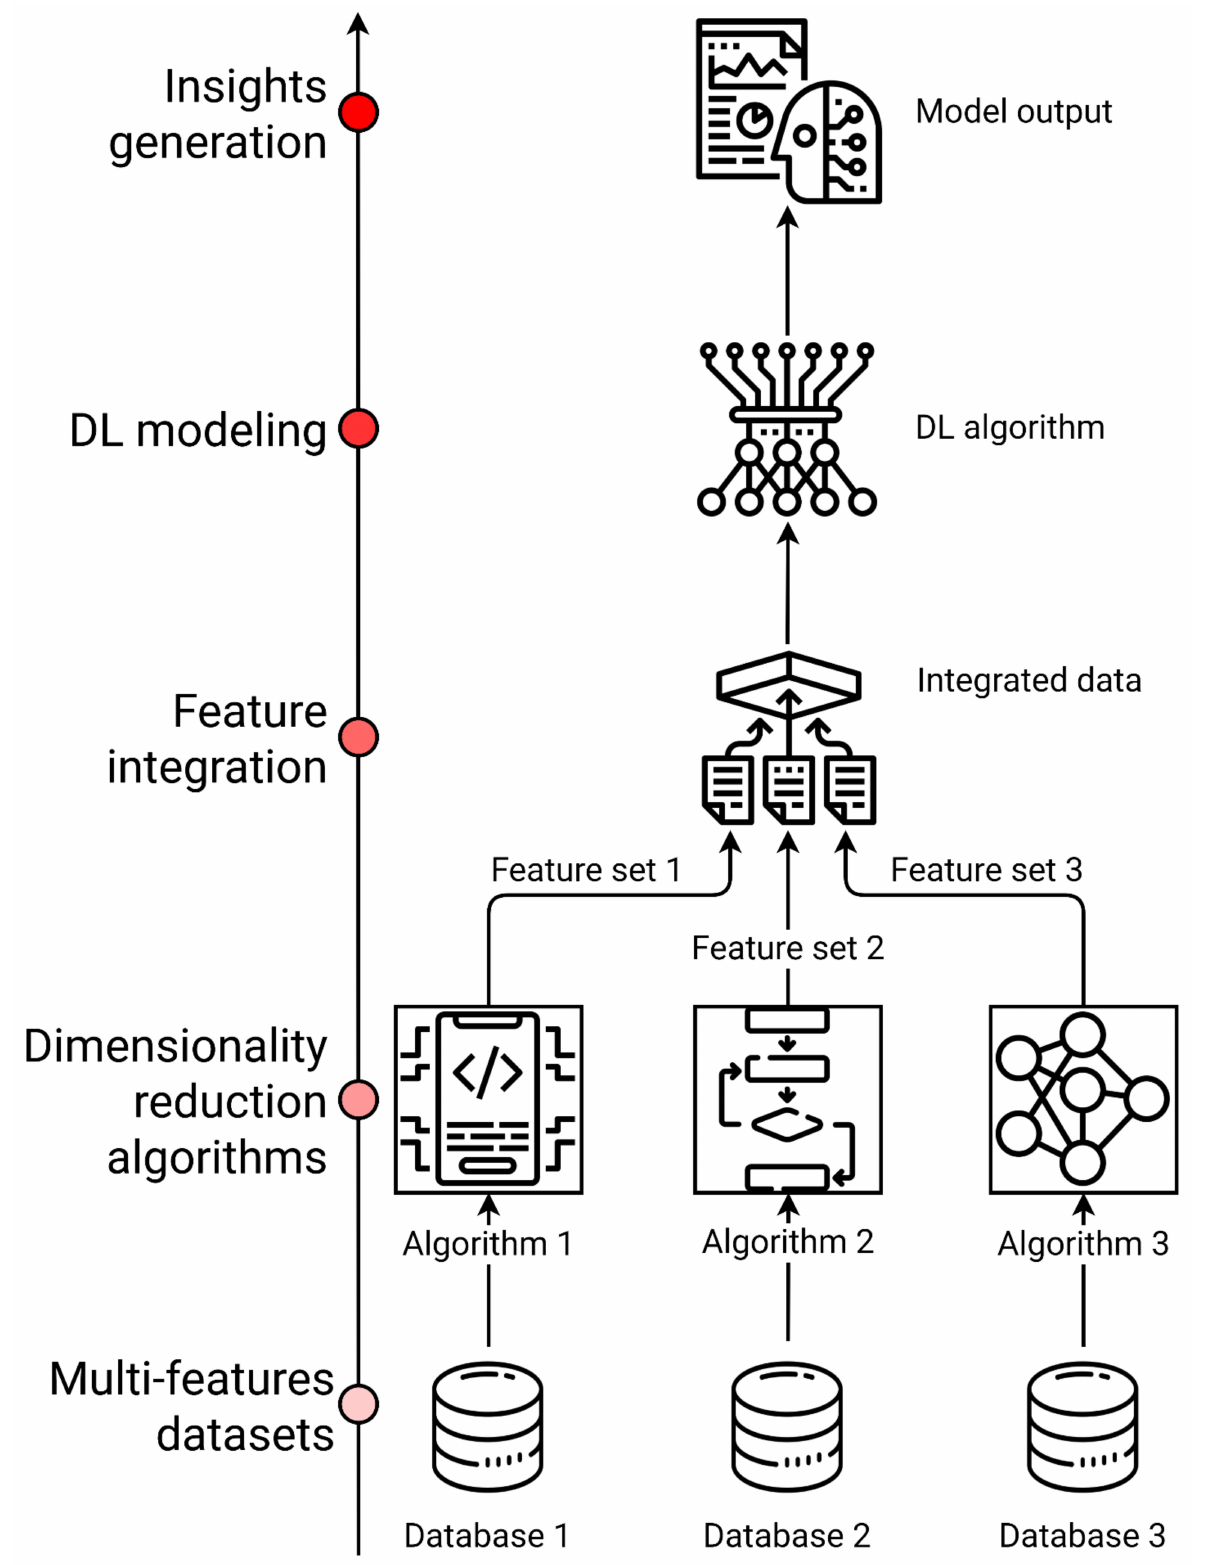
Figure 4. A DL workflow implementing dimensionality reduction strategies to integrate large and heterogeneous datasets. Dimensionality reduction algorithms can be applied to standard multi-omics data, integrating different features from the same set of observations or obtaining one outcome variable from different layers of biological